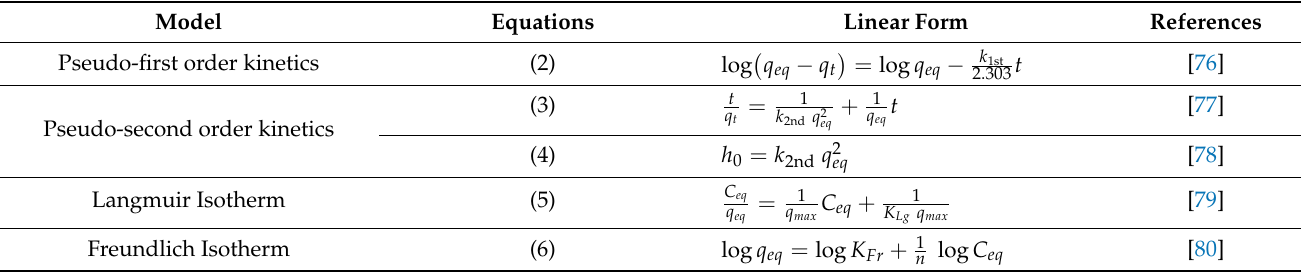
Table 1. Linear forms of kinetic and isotherm